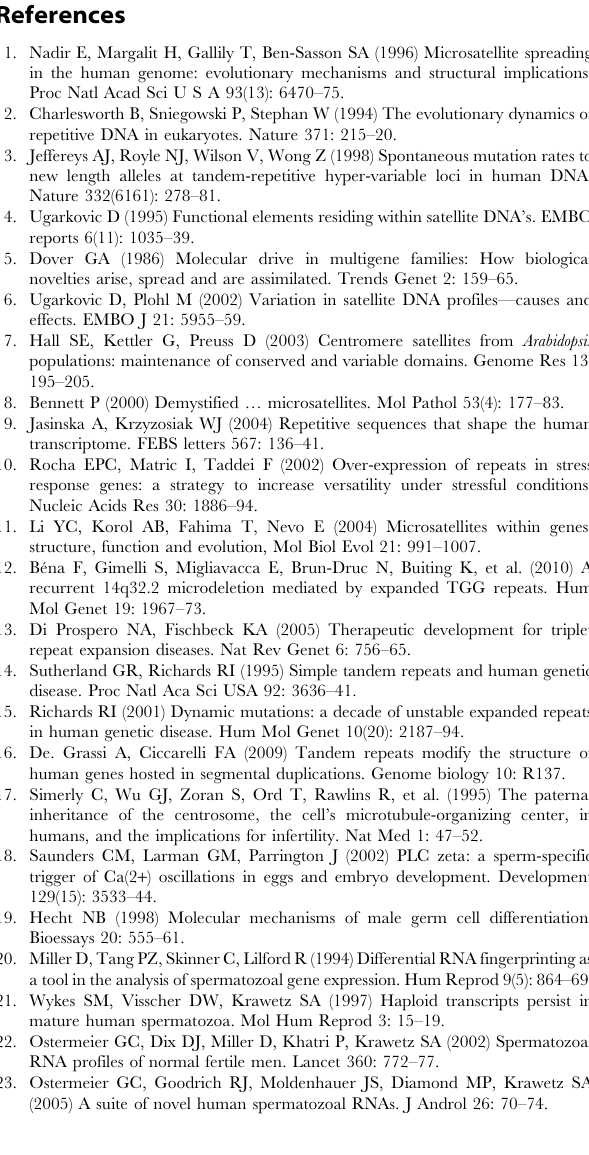
Table S3 List of primers used for RT-PCR on cDNA from different tissues (i) and semen (ii). The primer IDs and corresponding gene accession number of the amplified transcripts are given in the table. Table S4 List of primers used for q-PCR on cDNA from different tissues (i) and semen samples (ii). Table S5 List of primers used for obtaining full length CDS of the COL6A1 gene (i) and TSPY1 -like gene (ii). Table S6 Details of the clones corresponding to differ- ent mRNA transcripts uncovered by MASA